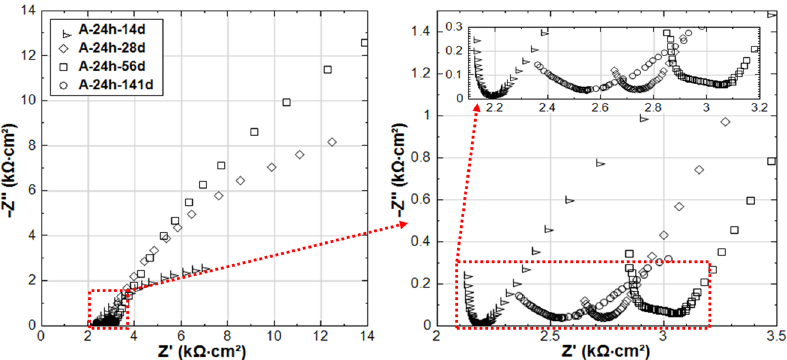
Figure 14. Overlay of EIS responses of A-24h in Nyquist format, at age of 14, 28, 56, and 141 days.